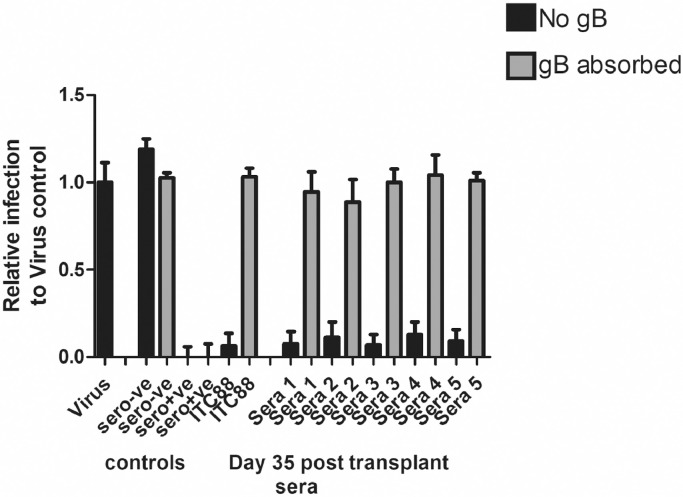
The neutralising activity in the seronegative vaccine sera is inhibited following pre-absorption with recombinant gB.Sera from healthy seronegative (sero-ve) and seropositive (sero+ve) individuals and sera from vaccinated seronegative SOT recipients collected 35 days post-transplant were diluted 1/10 and incubated with the virus prior to infection of the fibroblasts for 1 h (black bars). Alternatively, virus was incubated with ITC88 (100ug/ml) for 1 h prior to infection (ITC88 black bar). Additionally, each serum and ITC88 were also pre-incubated with the vaccine gB antigen prior to incubation with the virus in parallel (grey bars). Infection was measured by IE staining and the proportion of infected cells calculated by counterstaining nuclei with DAPI.